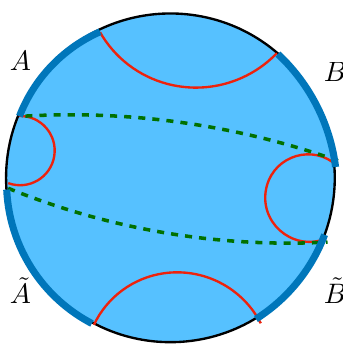
Figure 10 . The green surfaces are the additional boundary constraints which must be imposed to separate r ( AB ) and r ( ~ A ~ B